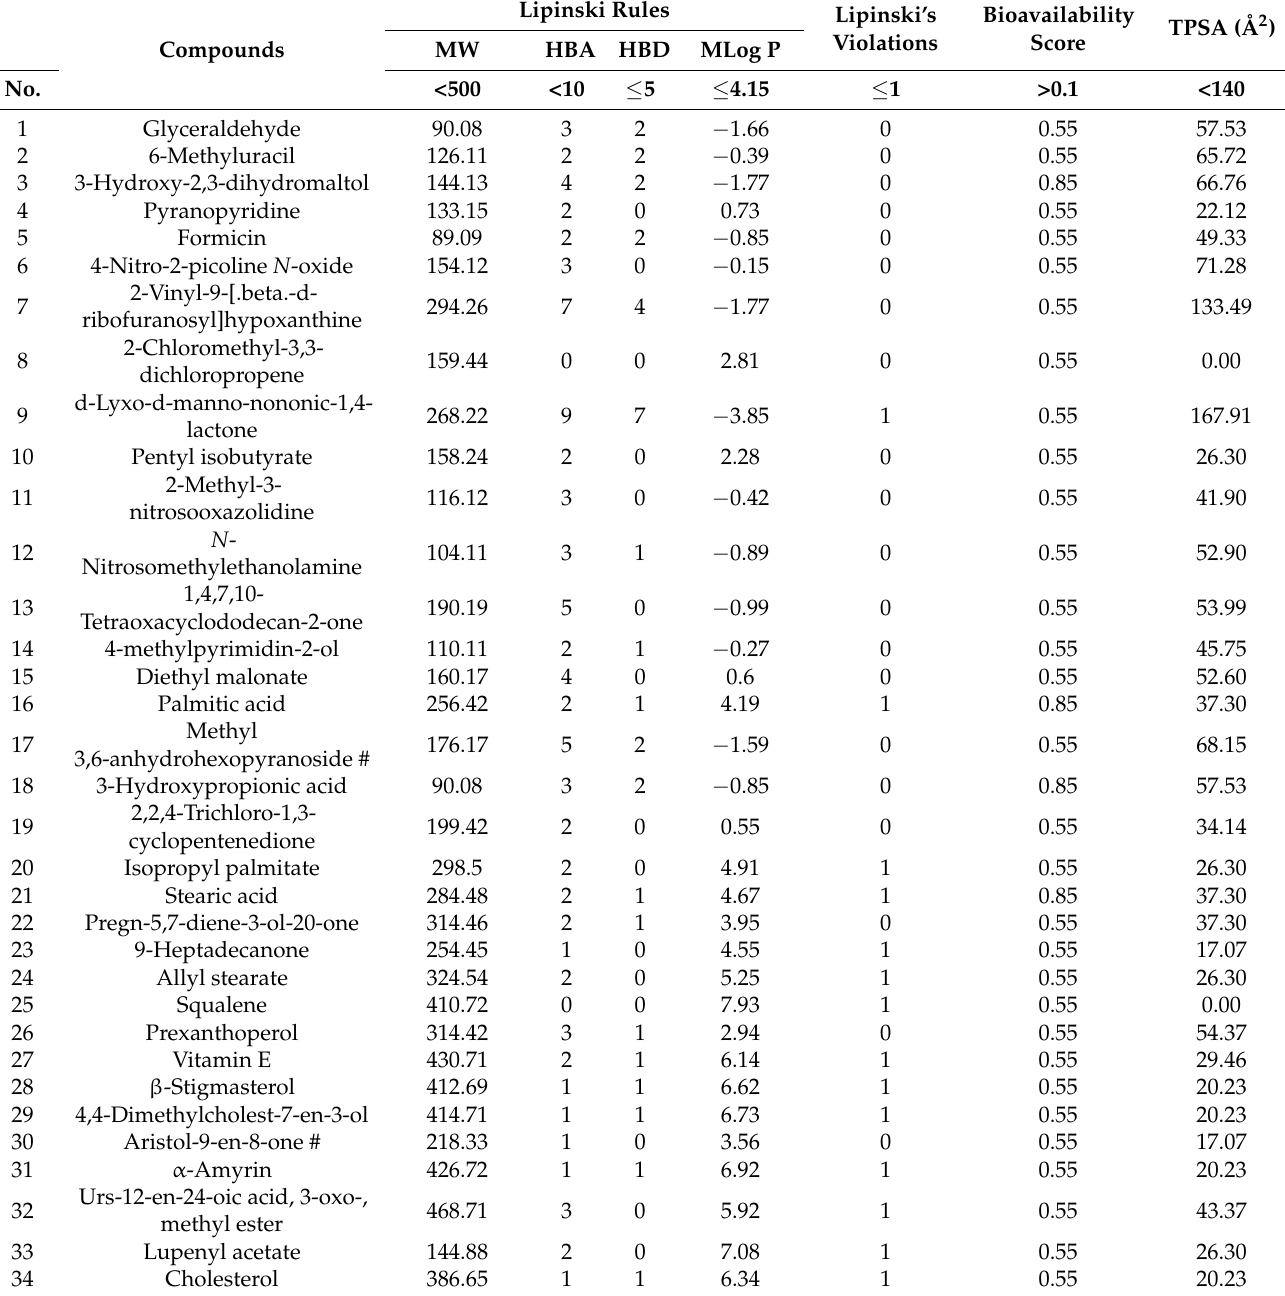
Table 2. Physicochemical properties of bioactives for good oral bioavailability and cell membrane permeability. Lipinski Rules Lipinski’s Bioavailability Violations Compounds